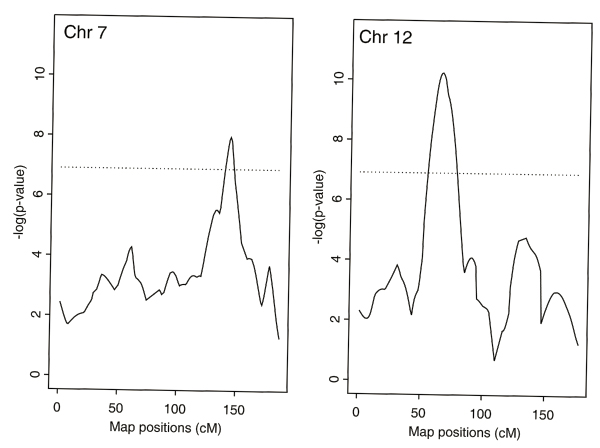
The multipoint linkage scans over chromosome 7 for ALDX1 and chromosome 12 for ALDX2, adjusting gender and smoking status as covariates. The dashed horizontal lines refer to the negative of the natural logarithm of 0.001 (i.e., -log(0.001)) corresponding to the significance level of 0.001.